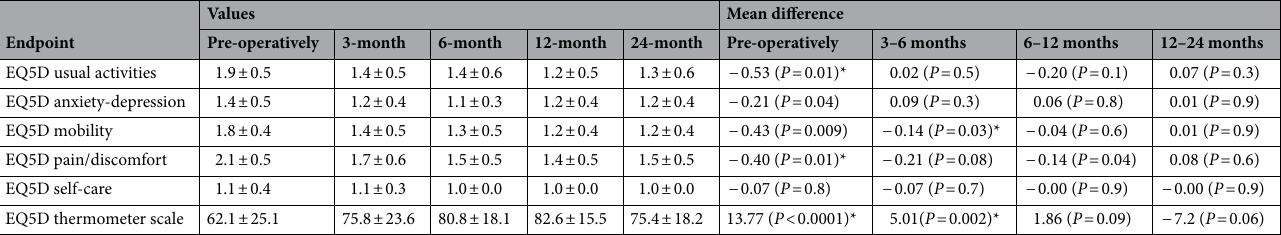
Table 2. Improvement of the EQ5D at the various follow-up appointments (*statistically significant following Bonferroni post-hoc correction).